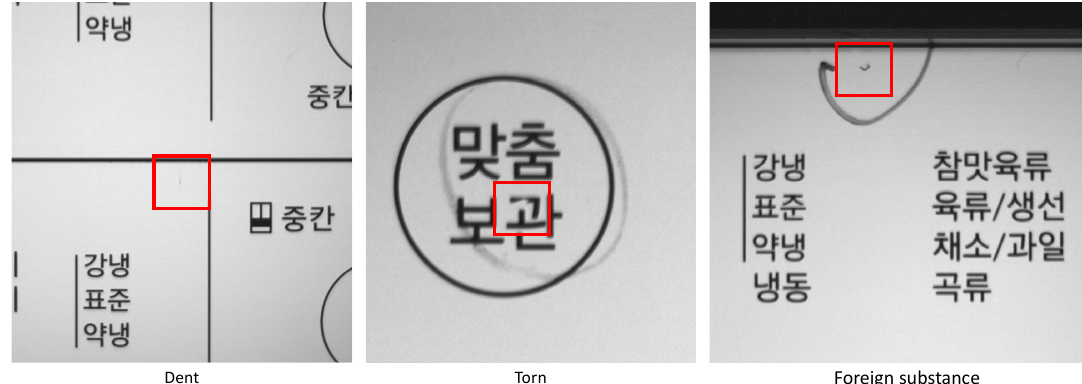
Figure 4. Examples of types of defects.